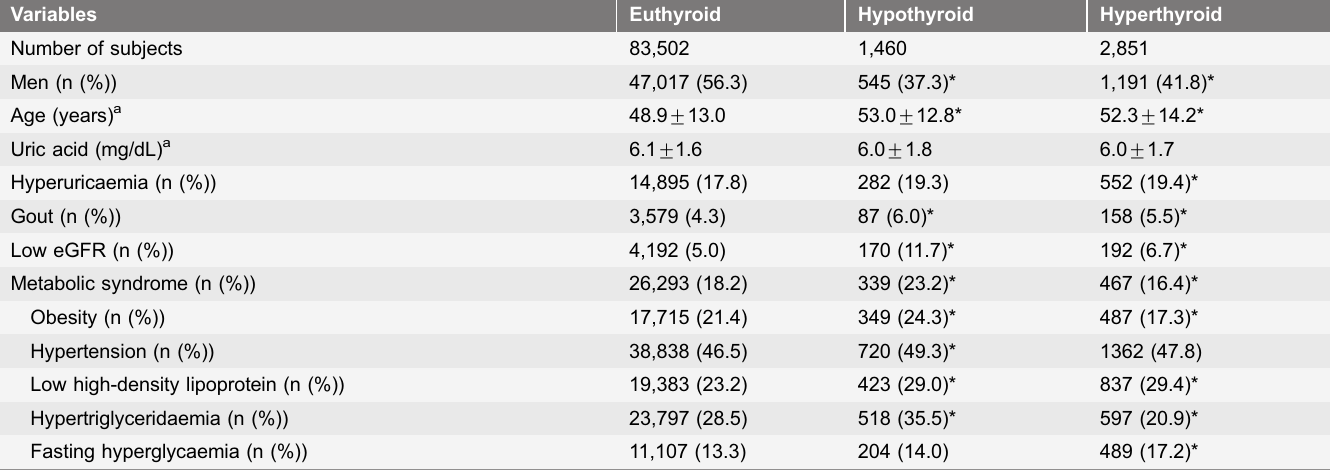
Table 1. Baseline characteristics of euthyroid, hyperthyroid and hypothyroid study